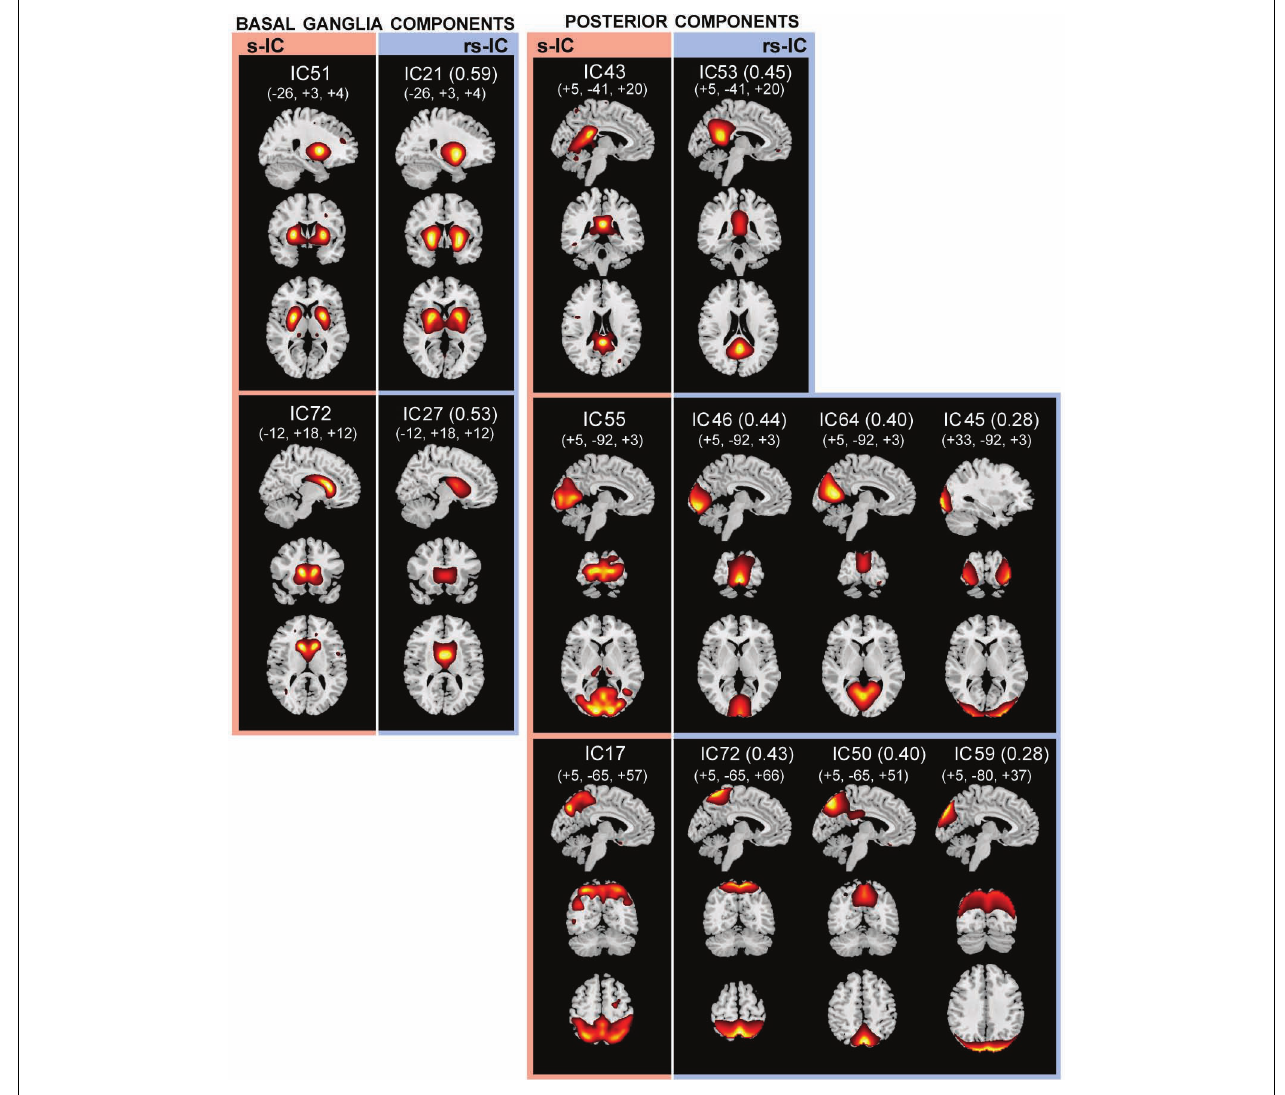
peak activation, indicated as ( x , y , z ) coordinates in MNI space.When structural components are paired with a single functional component, the functional component is displayed at the same slices. If a structural component corresponds to several fMRI components, functional components may be displayed at different coordinates that best represent their